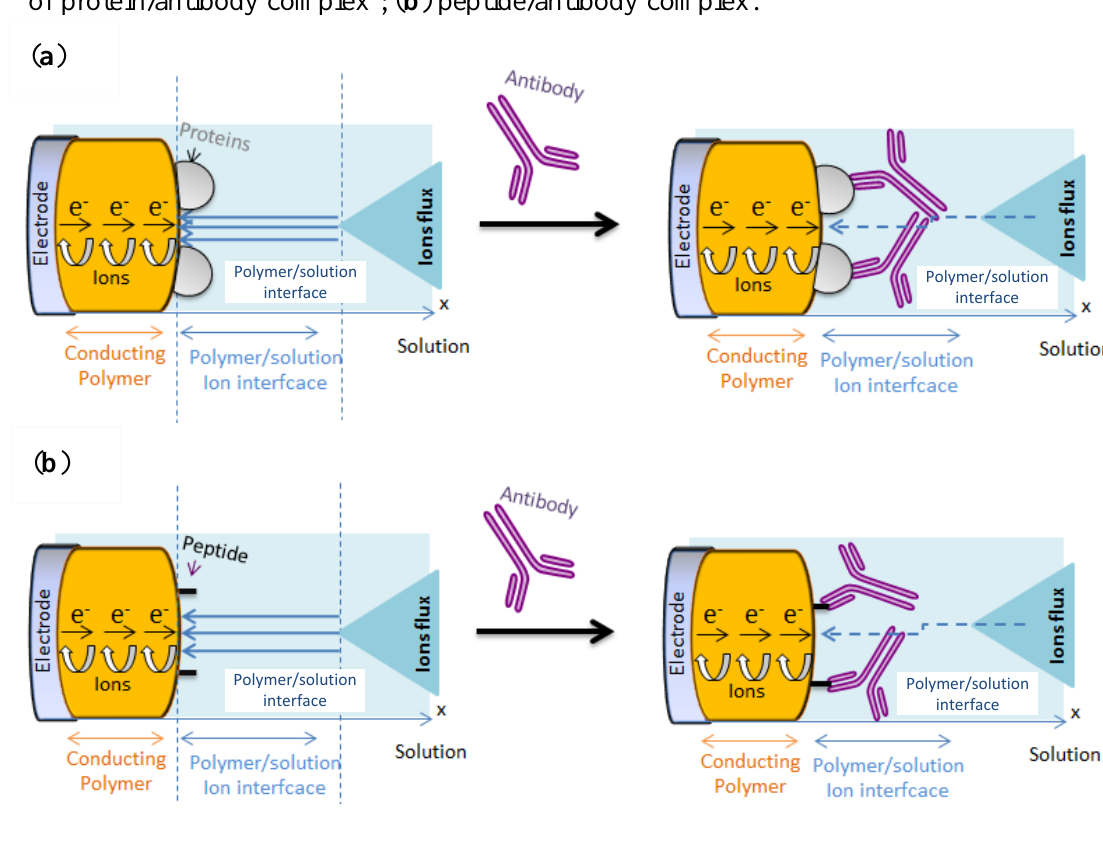
Figure 6. Transduction principle for poly(HNQ-co-HSNQA)/OVA/  OVA sensor ( a ) case of protein/antibody complex ; ( b ) peptide/antibody